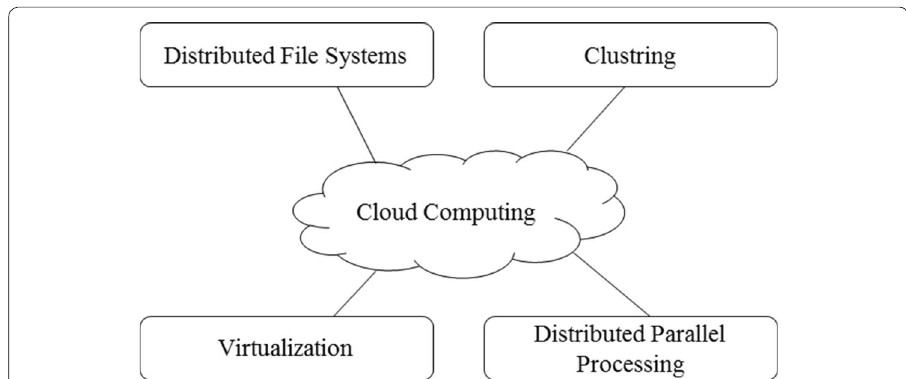
Data management in smart